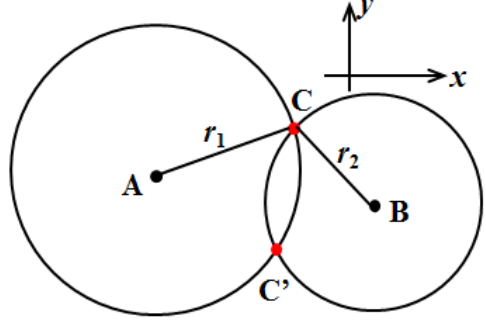
Figure 3. A schematic diagram to explain the time difference of arrival (TDOA) method. According to the above analysis, taking our localization system in Figure 1c into account, two situations were designed, with the ultrasonic sources located at the positions of (1.5, 1.5, 0.5) and (1.5, 0.5, 0.5). Figure 4 gives the time-domain responses of four MEMS-on-fiber sensors for the two ultrasonic signals. Obviously, due to the di ff erent position relationships, the four probes detected the appearance of the same ultrasonic signal at di ff erent times. By utilizing this property, we could calculate the target position, and the results were (1.4980, 1.5051, 0.5174) and (1.4996, 0.5169, 0.5182), respectively, which were in good accordance with the ideal